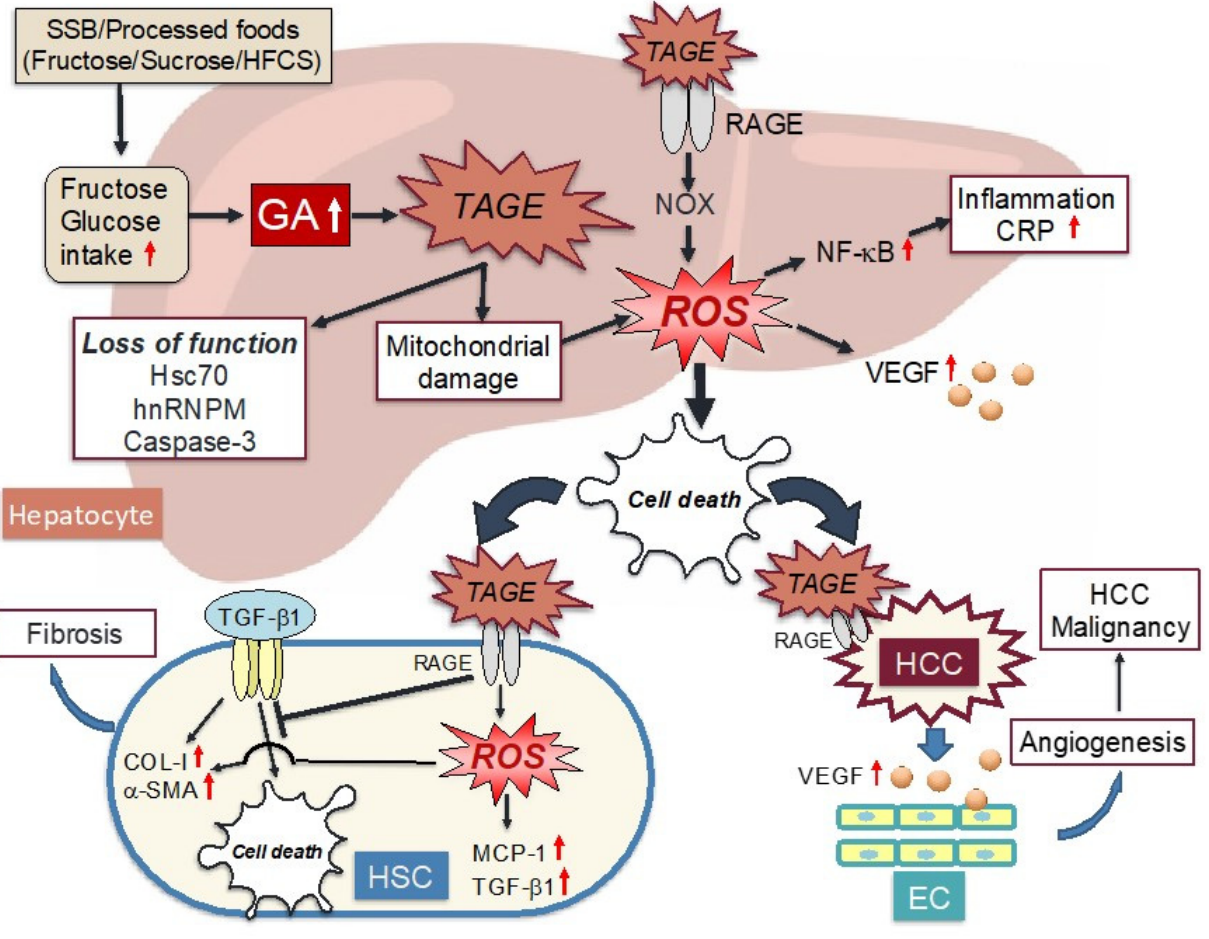
Figure 2. Involvement of intracellular TAGE and the TAGE–RAGE–ROS axis in the onset and progression of